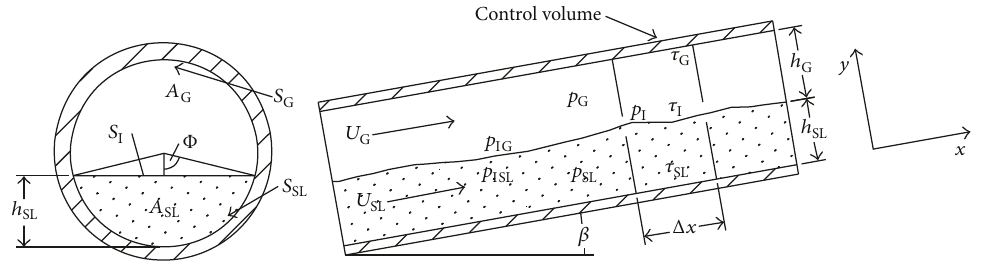
Figure 1: Sectional geometry of gas-hydrate slurry stratified